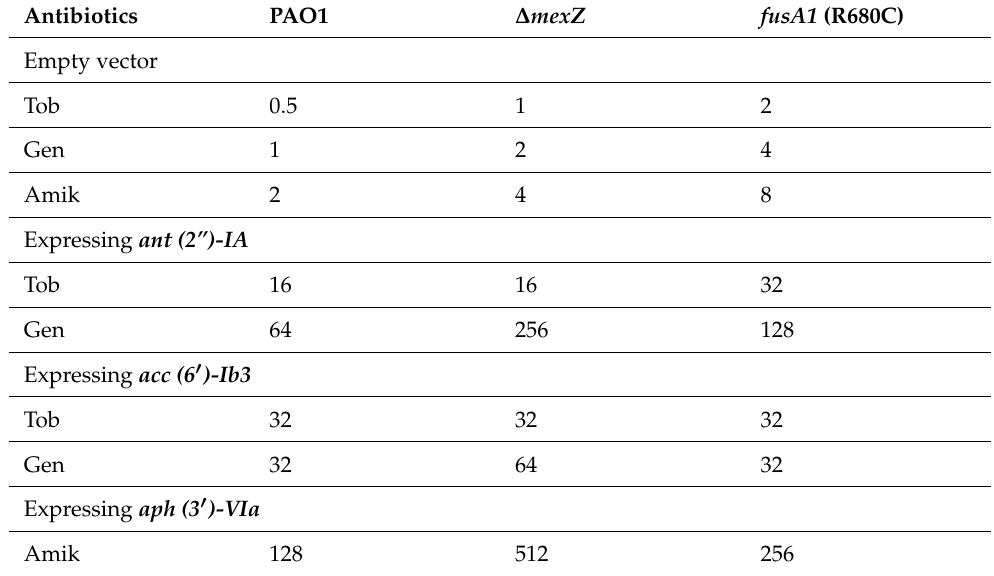
Table 3. Expressing aminoglycoside-modifying enzymes in the presence of additional